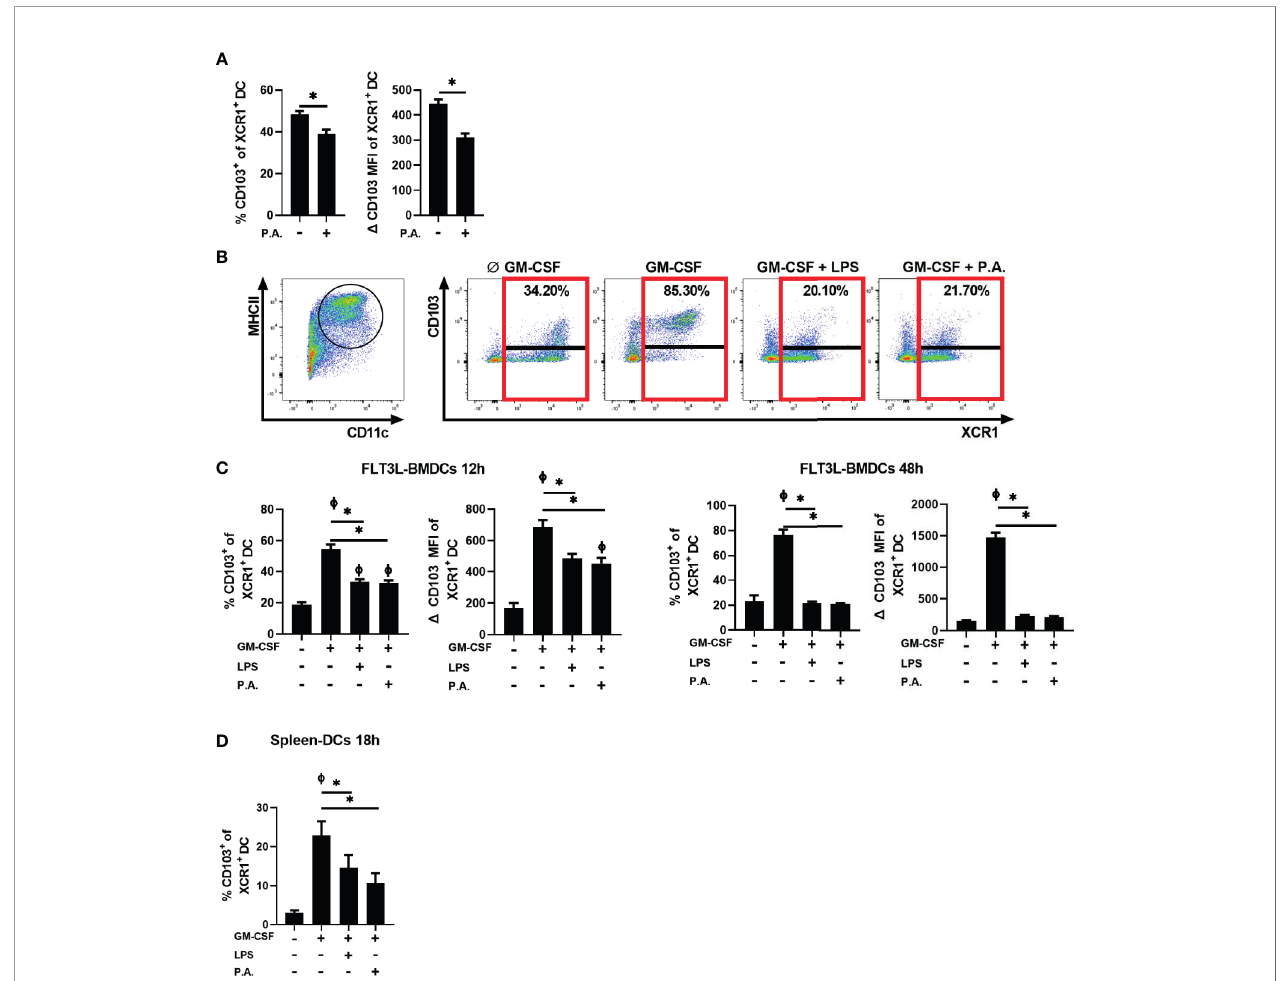
FIGURE 3 | P. aeruginosa stimulation prevents GM-CSF-induced CD103 expression on cDCs. (A) Mice were euthanized 18 h after a single i.n. instillation of 5 x 10 5 CFU of P. aeruginosa (P.A.) and the percentage of CD103 + cells and CD103 MFI in XCR1 + cDC1 gated lung cells were analyzed by fl ow cytometry. (B, C) FLT3L-BMDCs or (D) spleen-isolated cDCs were stimulated with GM-CSF ± LPS or P. aeruginosa (P.A.) for 12 h, 18 h or 48 h and CD103 and XCR1 expression were analyzed by fl ow cytometry. (B) Gating strategy used to identify MHC II Hi CD11c + cDCs and representative fl ow cytometry pro fi le of CD103 expression on XCR1 + FLT3L-BMDCs stimulated for 48 h. (C, D) Percentage of CD103 + cells and CD103 MFI from previously gated XCR1 + cDCs. Data are presented as mean ± SEM; ( A % CD103) n = 10-11 pooled from two separate experiments, ( A CD103 MFI) n = 5 representative of three separate experiments. ( C, D % CD103) n = 5-6 samples of cDCs per group pooled from two separate experiments. ( C, D CD103 MFI) n = 3 representative of two separate experiments. * = p < 0.05 compared between conditions stimulated with GM-CSF. F = p < 0.05 compared to unstimulated condition. P-values were analyzed using unpaired t-test (A) or paired-one-way ANOVA (C, D)